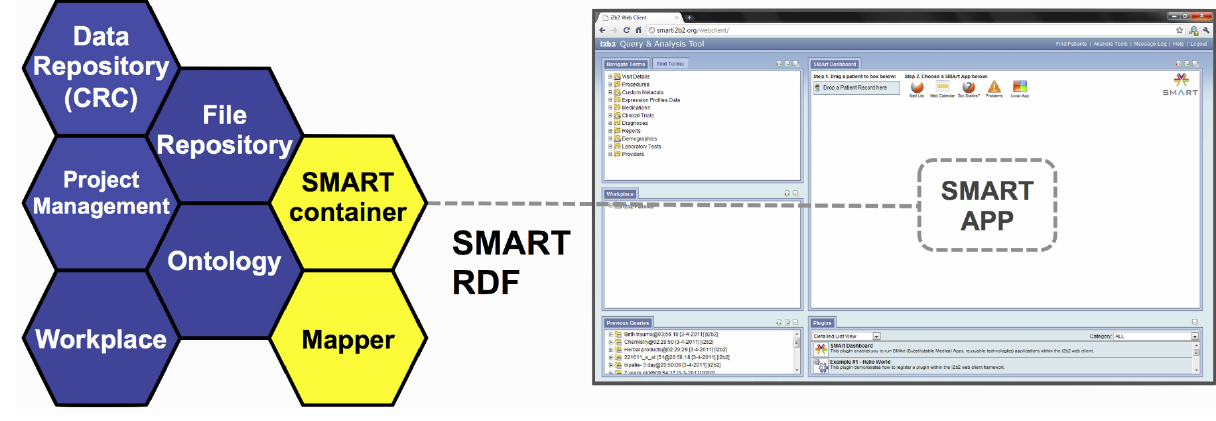
Figure 4. Left: i2b2 hive (blue) with SMART container and Mapper cells (yellow). Right: SMART Patient Centric view for the i2b2 Web